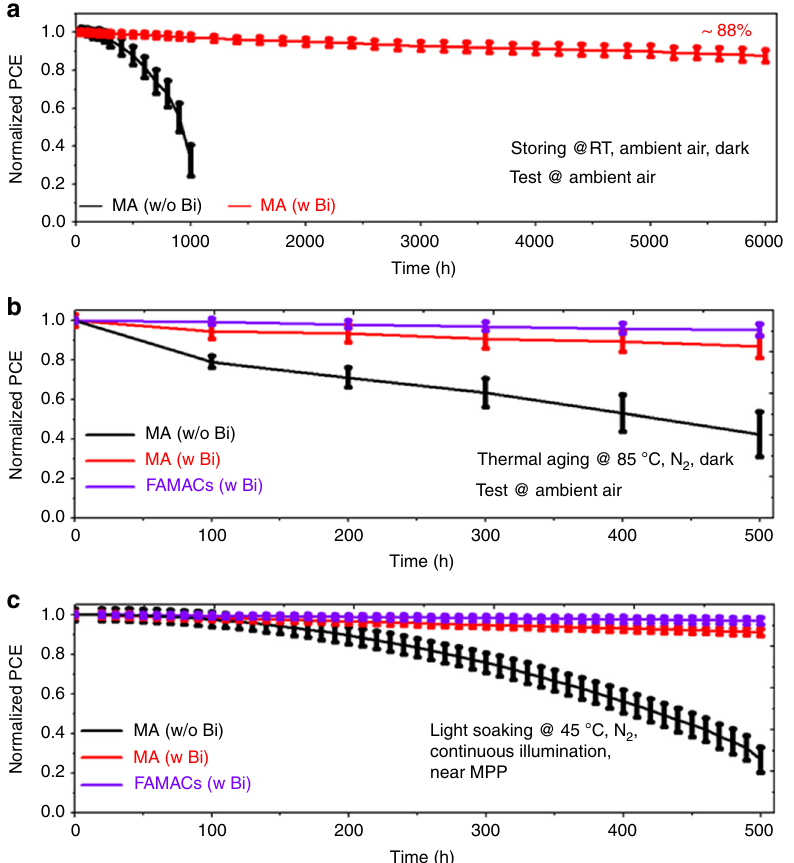
Fig. 6 Stabilities of unencapsulated HPVKSCs. The average ef fi ciency obtained as a function of time from 9 devices is shown with error bars that represent the standard deviation of the devices. a Stored in the dark in ambient air at RT without humidity control, and J – V curves acquired periodically in ambient air; b aged in the dark at 85 °C in an N 2 atmosphere, and J – V curves acquired periodically in ambient air. The device performance measurements in ( a , b ) were measured under standard AM1.5G simulated sunlight; c aged under continuous illumination in an N 2 atmosphere with electrical biases (0.641 – 0.885 V) near MPP at a cell temperature of 45 °C. The light intensity for aging was generated by a white light LED array and calibrated to achieve the same J SC from the HPVKSCs as for 1 sun AM1.5G solar irradiation. Source data are provided as a Source Data fi